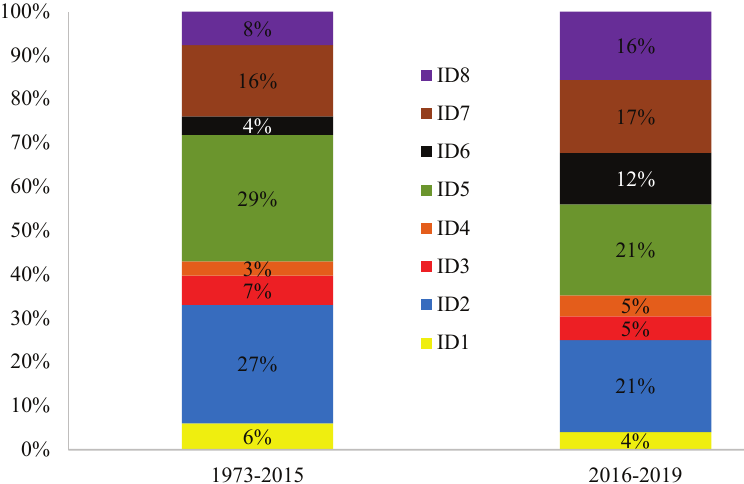
Figure 6. Comparison between the first and second half research